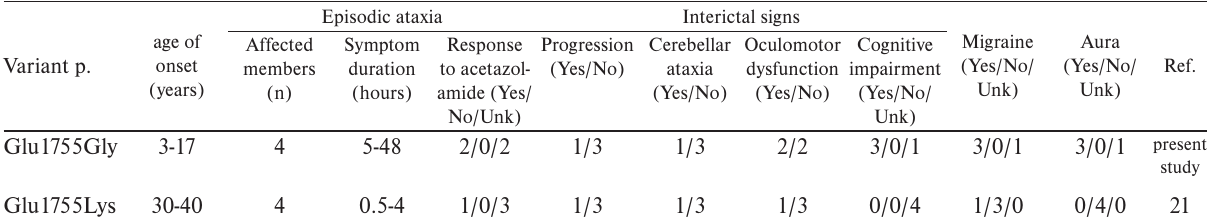
Table 1. Clinical comparision of the two CACNA1A variants p.Glu1755Gly and p.Glu1755Lys.